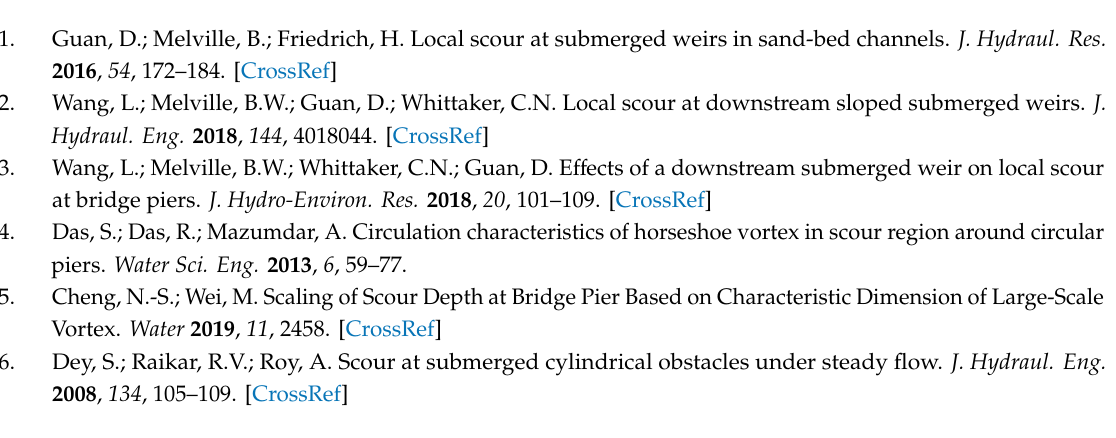
Figure S1: The validity ranges of the ten membership functions of the predictive variables employed in the present study, (a) U 0 , (b) d 50 , and (c) z , Figure S2: The validity ranges of the five membership functions of the predictive U C h t h t variables employed in the present study, (a) U 0 , (b) d 50 , and (c) z , Table S1: Description of the dataset U C h t h t